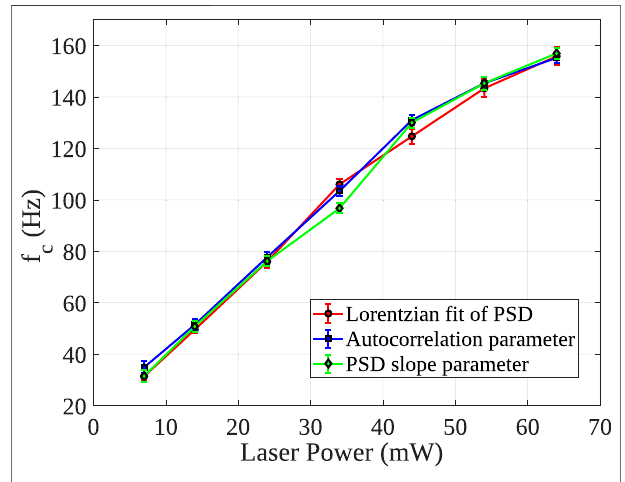
FIGURE8| Linear variation ofcorner frequency withlaserpower, also at lower trapping potentials. The points are plotted with 1 σ error bar. Note that the measurements from our method agree very well with that obtained by power spectrum analysis.